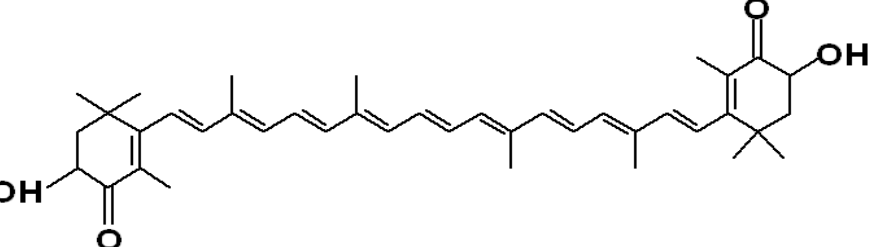
Figure 1. Structure of astaxanthin.